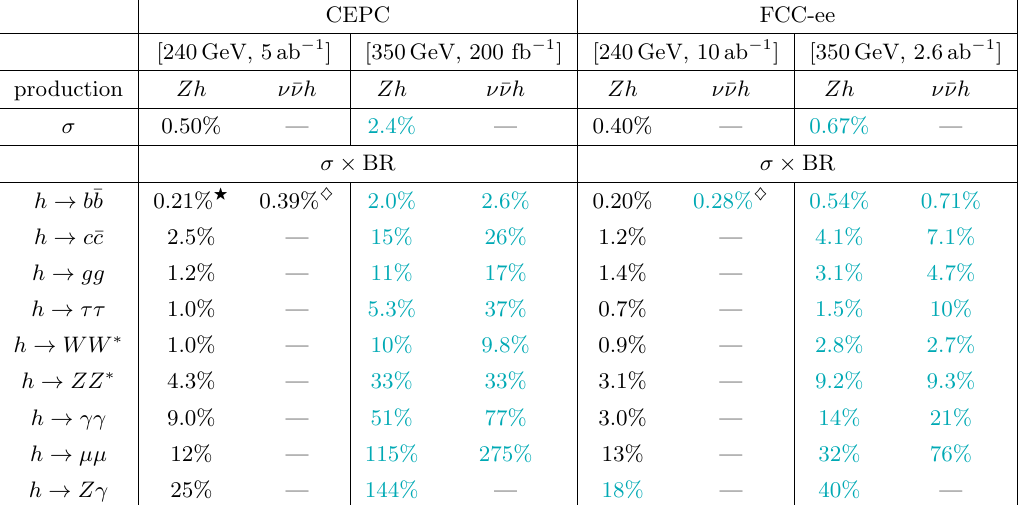
h ! (cid:13)(cid:13)